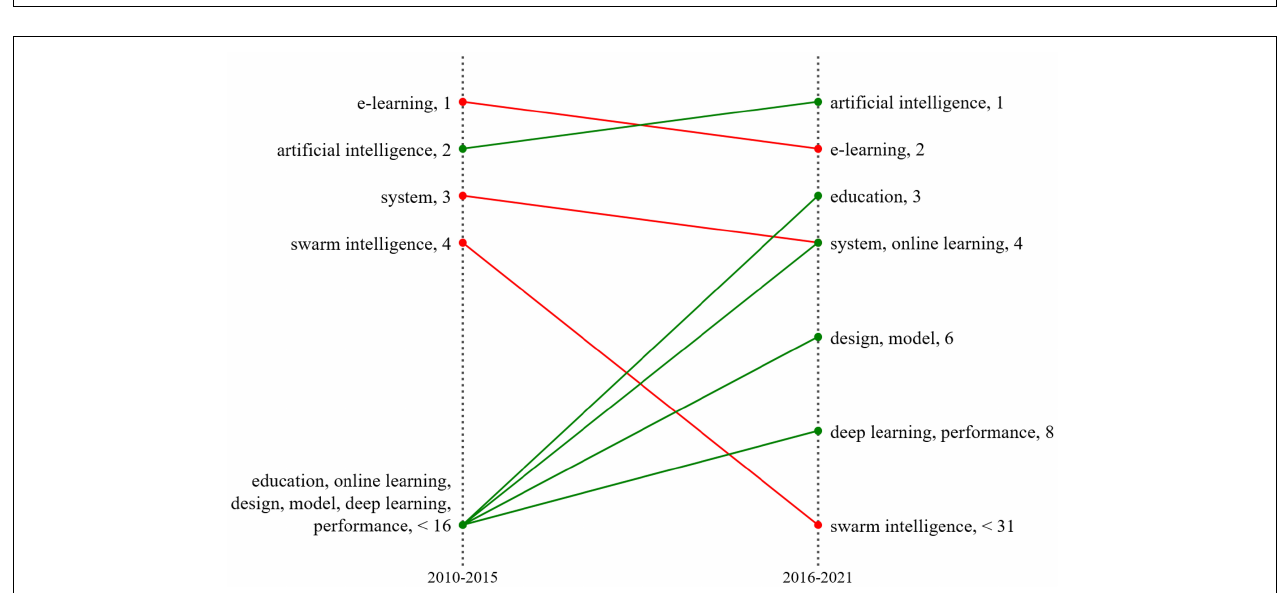
FIGURE 5 | Analysis of keyword co-occurrence from 2010–2021.